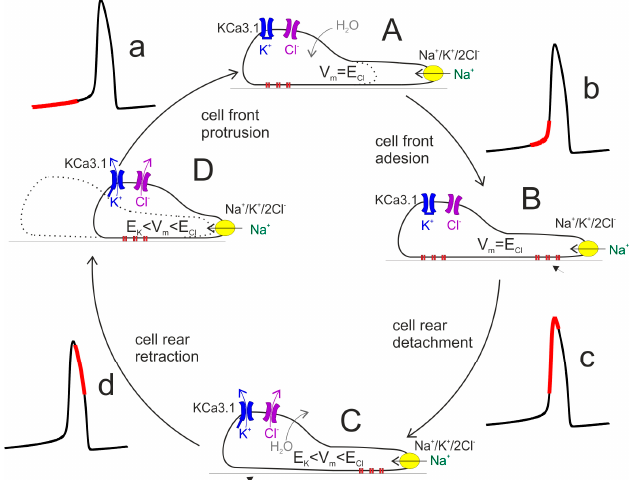
Figure 4. Schematic diagram of cell migratory cycle. The classic view of the cell migration process can be split down into four main cyclical steps. The cycle begins with the cell front protrusion, due to the activity of Na + /K + /2Cl − cotransport (yellow) ( A ) and establishment of adhesion structures ( B ). The elongated cell then removes/weakens the rear adhesions ( C ) so that ensuing contraction can pull the rear cell portion forward ( D ). The concomitant values of [Ca 2+ ] i is indicated by the red portion on the associated Ca 2+ oscillation. V m , ion and water fluxes are also illustrated (see text for details).